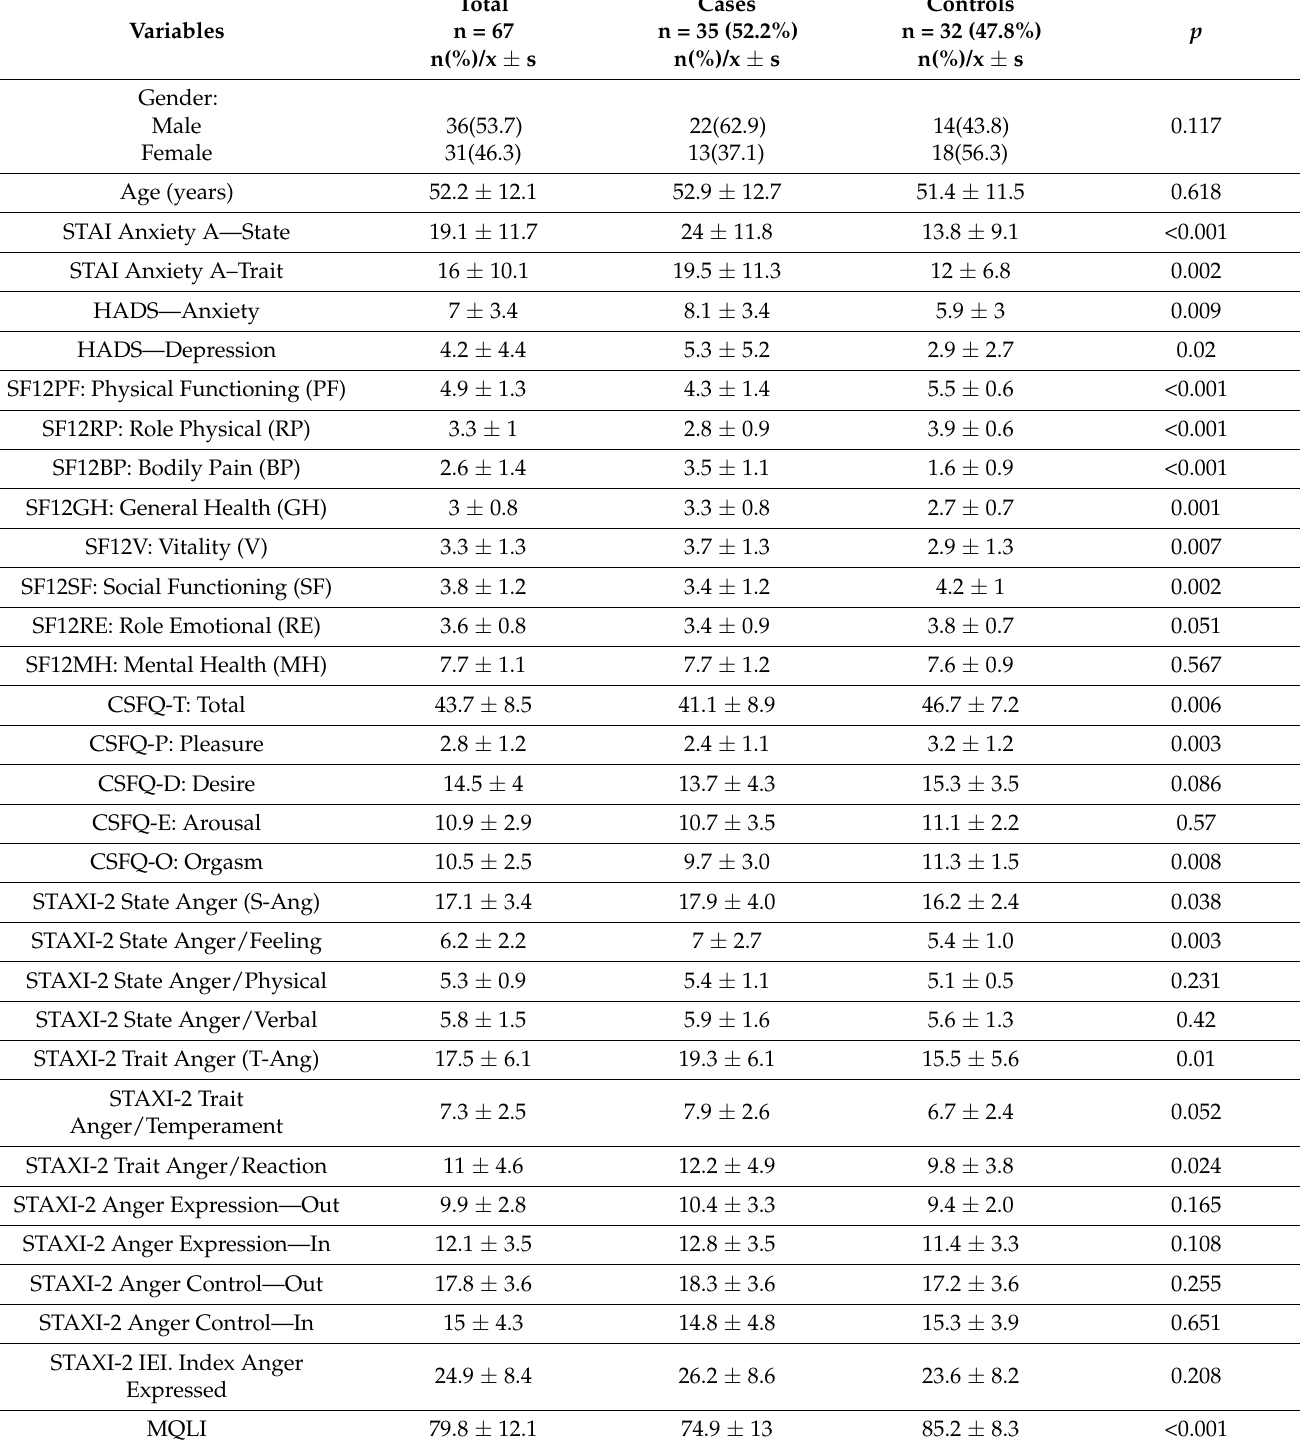
Table A1. Descriptive and bivariate